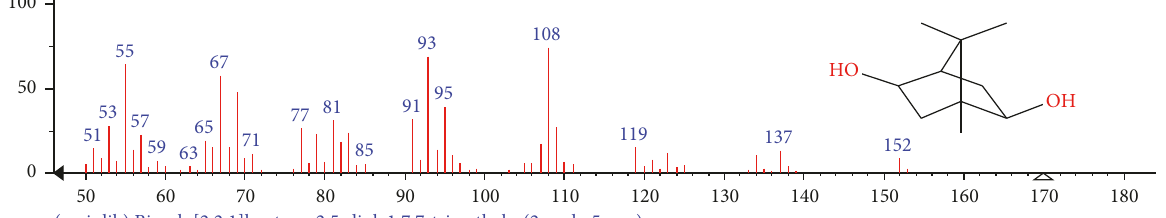
Figure 10: Mass spectrum of compound bicyclo[2.2.1]heptane-2,5-diol, 1,7,7-trimethyl-, (2-endo,5-exo)- of whole plant hexane fraction of Achillea wilhelmsii (WHFAW).